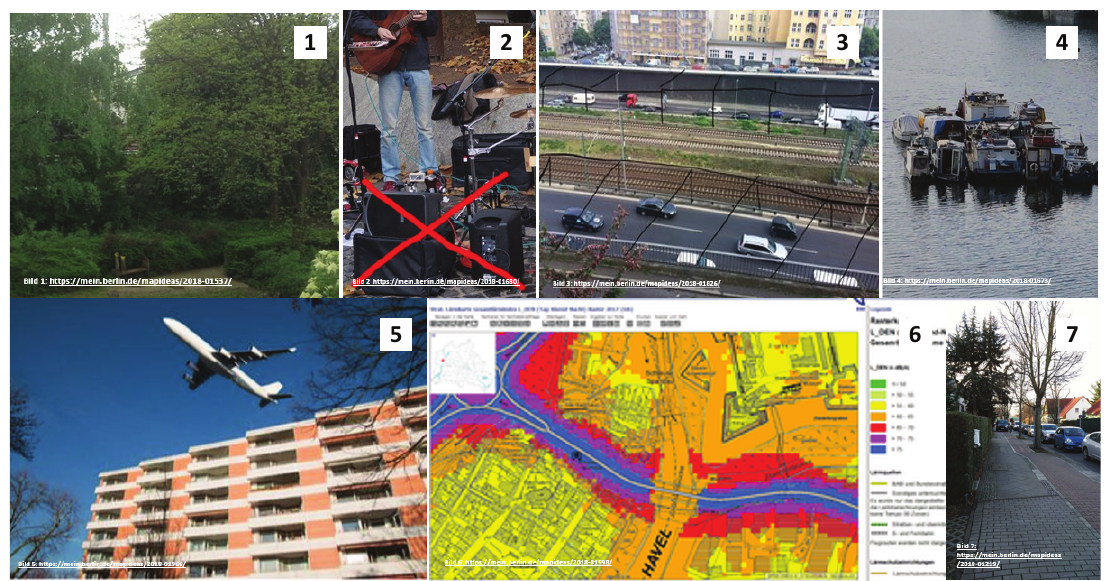
Figure 2. Collage of communicated noise visualisations by citizens. Compiled by the authors based on images from the ‘meinBerlin’